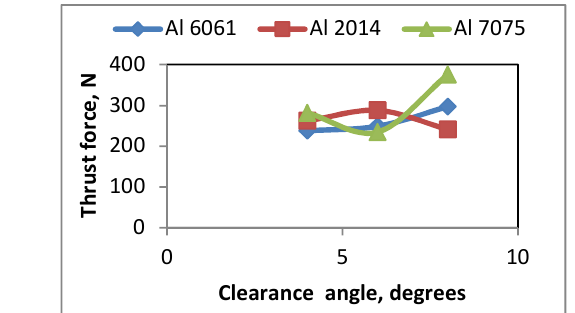
Fig. 13. Effect of modifying the clearance angle on thrust force